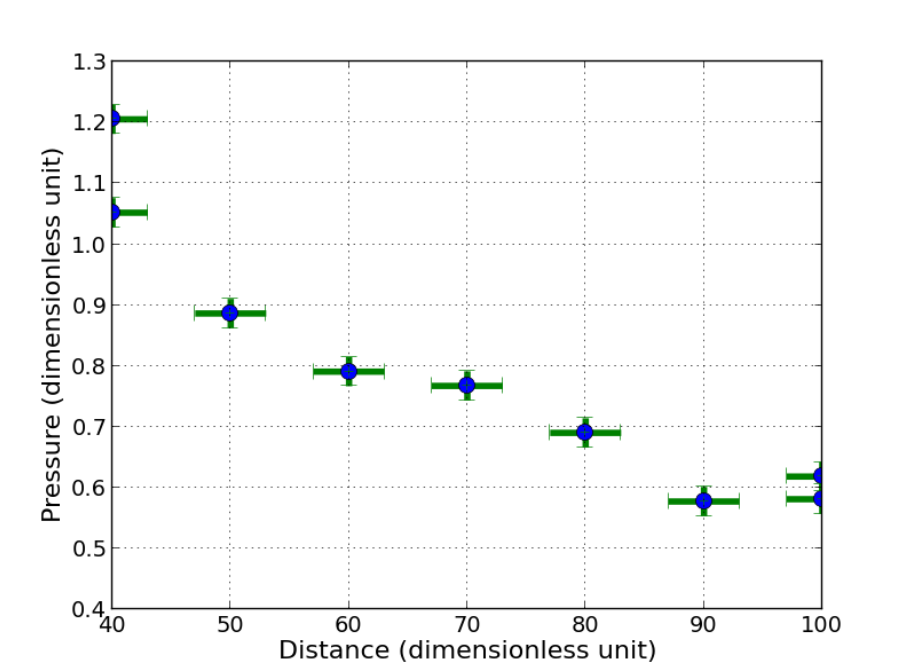
Figure 7. Measured peak pressures with sensor on steel anvil versus distance with one detonating cord (dimensionless